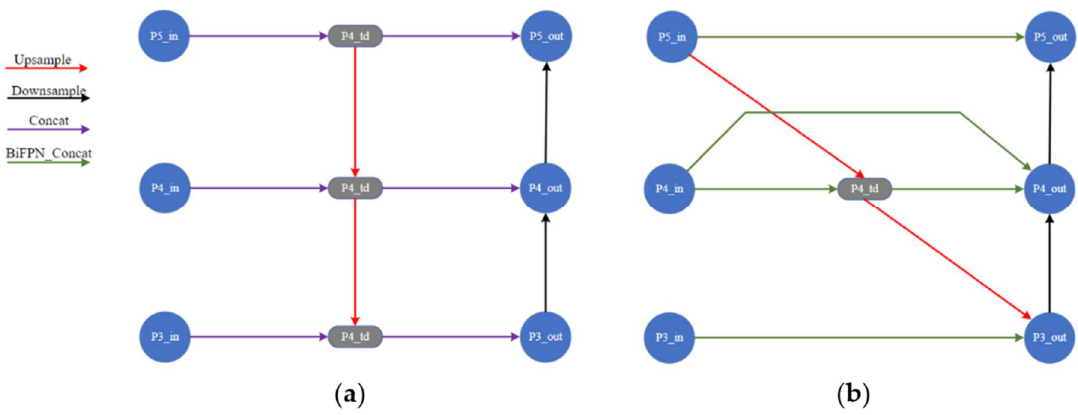
Figure 6. The PANet multiscale feature fusion network was replaced by BiFPN with two-way cross-scale connection and weighted feature fusion: ( a ) PANet; ( b ) BiFPN.